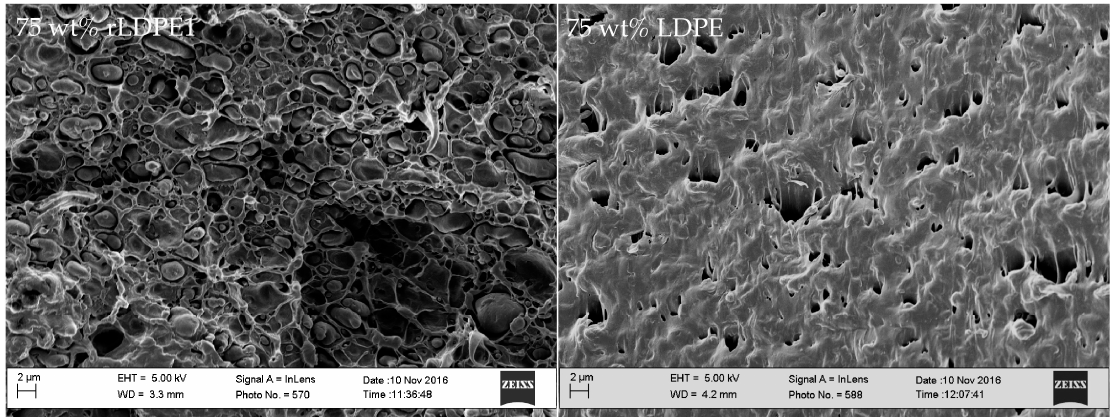
Figure 12. SEM images for vPP1 / vLDPE1 (left) and PP / LDPE (right) at 25 wt % of LDPE composition, sulfuric etching at 80 ◦ C for 2